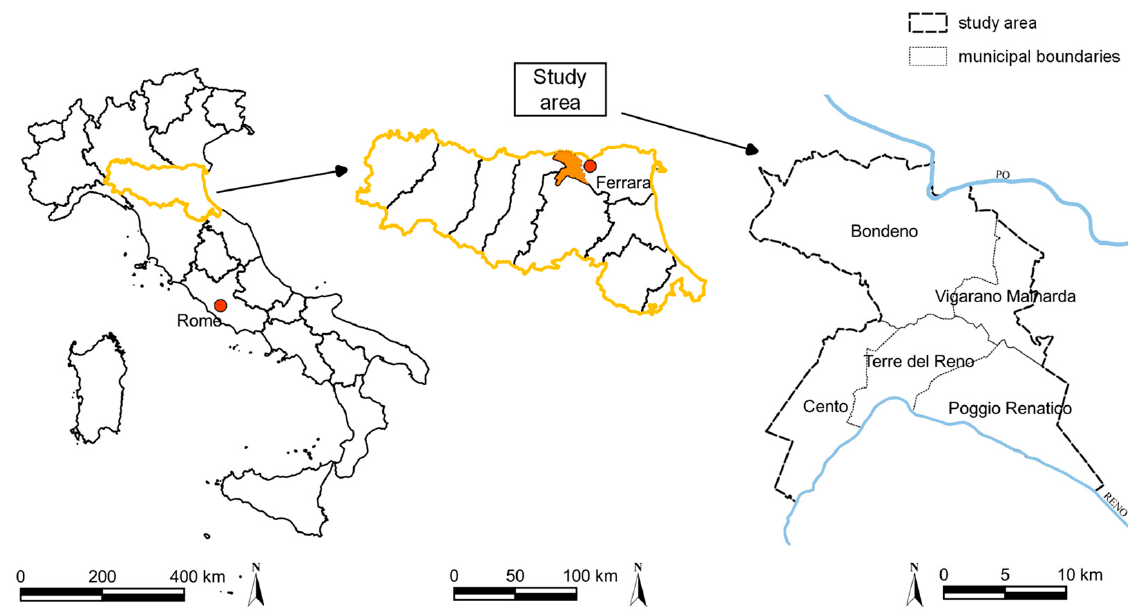
Figure 3. Case study area.